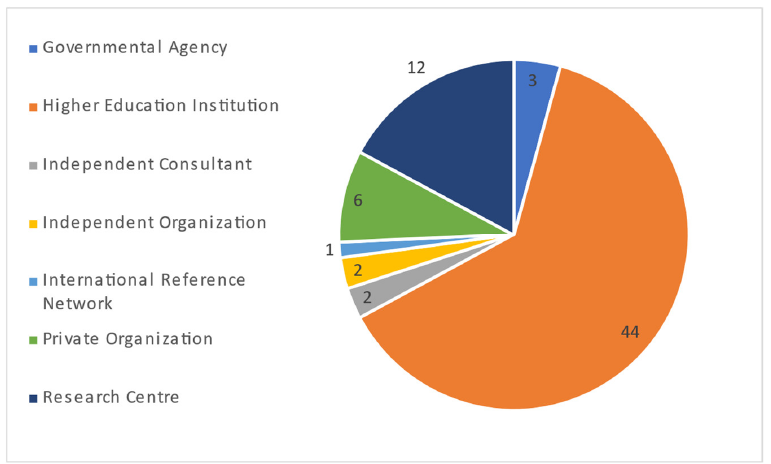
Figure 4. Number of Organizations per Type of Entity.